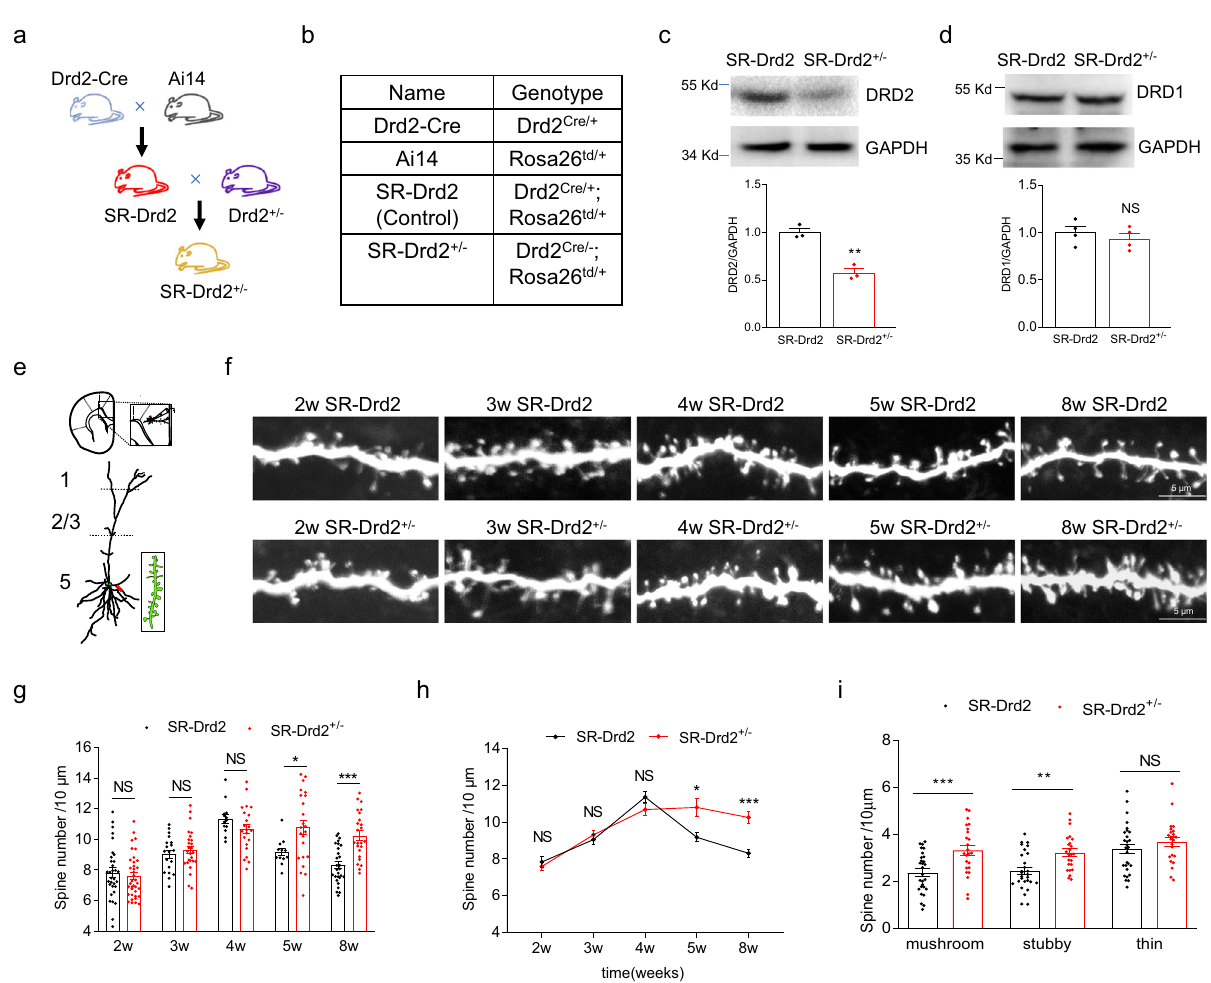
Fig. 2 Regulation of dendritic spine pruning but not formation by Drd2. a The strategies to generate SR-Drd2 (control) and SR-Drd2 + / − rats. The SR- Drd2 rats were generated by crossing Drd2-Cre rats with Ai14 (Rosa26-LSL-tdTomato) rats. The SR-Drd2 + / − rats were generated by crossing SR-Drd2 rats with Drd2 + / − rats. b The genotypes of different lines of rats. c Decreased DRD2 protein levels in the ACC of SR-Drd2 + / − rats. The homogenates of ACC from SR-Drd2 and SR-Drd2 + / − rats were subjected to western blot and probed with anti-DRD2 and anti-GAPDH antibodies (top). Quanti fi cation of DRD2/GAPDH (bottom). ** P = 0.0022, two-sided t -test, n = 3 for each group, data were normalized to controls. Data are presented as mean values ± SEM. d Unchanged DRD1 protein levels in the ACC of SR-Drd2 + / − rats. The homogenates of ACC from control and SR-Drd2 + / − rats were subjected to western blot and probed with anti-DRD1 and anti-GAPDH antibodies (top). Quanti fi cation of DRD1/GAPDH (bottom). NS not signi fi cant, P = 0.4812, two-sided t -test, n = 4 for each group, data were normalized to controls. Data are presented as mean values ± SEM. e Schematic diagram showing the dendrites of Drd2-positive neurons fi lled with biocytin in layer 5 of ACC. We analyzed the spines of the secondary basal dendrites. f Representative dendritic spines of Drd2-positive neurons from different aged control and SR-Drd2 + / − rats. Scale bar, 5 μ m. g De fi cient synaptic pruning but not synapse formation of Drd2-positive neurons in SR-Drd2 + / − rats. The spine densities of Drd2-positive neurons in different aged control and SR- Drd2 + / − rats were quanti fi ed. NS not signi fi cant, P (2w) = 0.9718, two-way ANOVA followed by Sidak ’ s multiple comparisons test, n = 32 dendrites from 5 control rats, n = 37 dendrites from 5 SR-Drd2 + / − rats. P (3w) = 0.9831, two-way ANOVA followed by Sidak ’ s multiple comparisons test, n = 19 dendrites from 4 control rats, n = 26 dendrites from 5 SR-Drd2 + / − rats. P (4w) = 0.6744, two-way ANOVA followed by Sidak ’ s multiple comparisons test, n = 13 dendrites from 3 control rats, n = 22 dendrites from 4 SR-Drd2 + / − rats. * P = 0.0133, two-way ANOVA followed by Sidak ’ s multiple comparisons test, n = 12 dendrites from 3 control rats, n = 23 dendrites from 4 SR-Drd2 + / − rats. *** P < 0.0001, two-way ANOVA followed by Sidak ’ s multiple comparisons test, n = 28 dendrites from 5 control rats, n = 24 dendrites from 4 SR-Drd2 + / − rats. Data are presented as mean values ± SEM. h Line chart of the data in panel g . The statistical results are same as panel g . * P = 0.0133, two-way ANOVA followed by Sidak ’ s multiple comparisons test, n = 12 dendrites from 3 control rats, n = 23 dendrites from 4 SR-Drd2 + / − rats. *** P < 0.0001, two-way ANOVA followed by Sidak ’ s multiple comparisons test, n = 28 dendrites from 5 control rats, n = 24 dendrites from 4 SR-Drd2 + / − rats. Data are presented as mean values ± SEM. i Increased densities of mushroom-like and stubby spines in Drd2-positive neurons from SR-Drd2 + / − rats, compared with control rats. The densities of different types of dendritic spines in Drd2-positive neurons from 8-week-old control and SR-Drd2 + / − rats were quanti fi ed. NS not signi fi cant, P = 0.5398, ** P = 0.0068, *** P = 0.0008, two-way ANOVA followed by Sidak ’ s multiple comparisons test, n = 28 dendrites from 5 control rats, n = 24 dendrites from 4 SR-Drd2 + / − rats. Data are presented as mean values ±